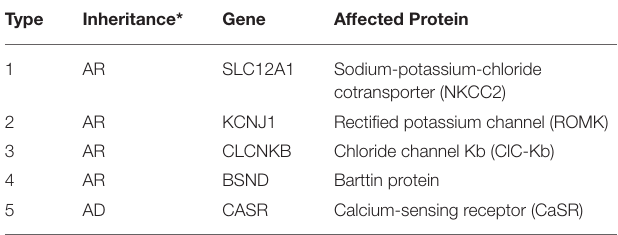
(G to A) in exon 2 (NM_198488.2:C.154G > A), leading to amelogenesis imperfecta type 3 (OMIM: 130900).